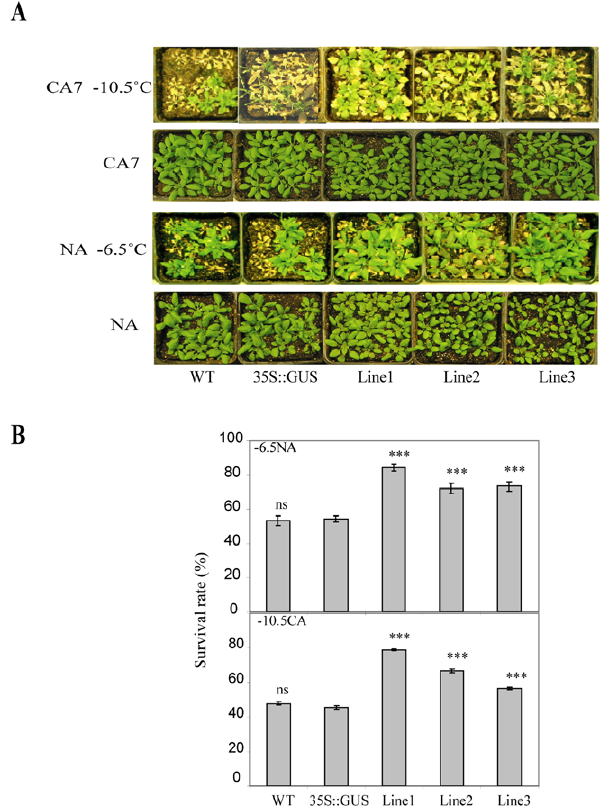
Figure 6. TaVRN-B2 enhances freezing tolerance in Arabidopsis . A) Control and transgenic plants after freezing test. Plants were grown for 3 weeks at 20 u C (NA) or grown for 3 weeks at 20 u C then transferred to 4 u C for 7 days (CA7). Controls plants wild type (WT) and 35S::GUS ), transgenic 35S::TaVRN-B2 lines (Line1–Line3). Plants were subjected to freezing test (NA frozen to 2 6.5 u C and CA7 frozen to 2 10.5 u C). Pictures were captured for the same plants before the freezing and after a recovery period of 2 weeks. B) Survival rate after freezing stress expressed as a percent of surviving plants. A statistical difference measurements from three independent experiments (n=33). The threshold for statistical significance is indicated by an asterisk on top of each histogram columns; comparison between GUS and the three LINES; *: P , 0.05, **: P , 0.01, ns: P . 0.05.